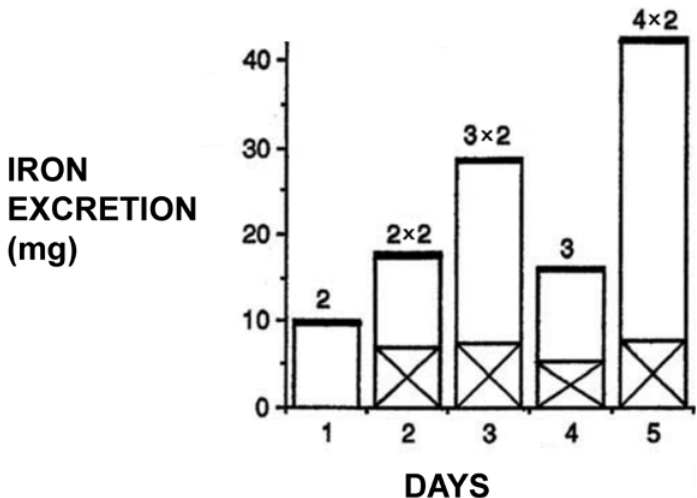
Figure 4. Iron excretion profile in a thalassemia major patient following the daily administration of different doses of oral deferiprone (L1). Iron excretion (mg) in the urine is shown in the open columns and fecal iron excretion in the x columns. Iron excretion is dose-dependent, as shown from the doses (g) of deferiprone (L1) at the top of the column. It should be noted that almost all excess iron is excreted in the urine (see [81]).